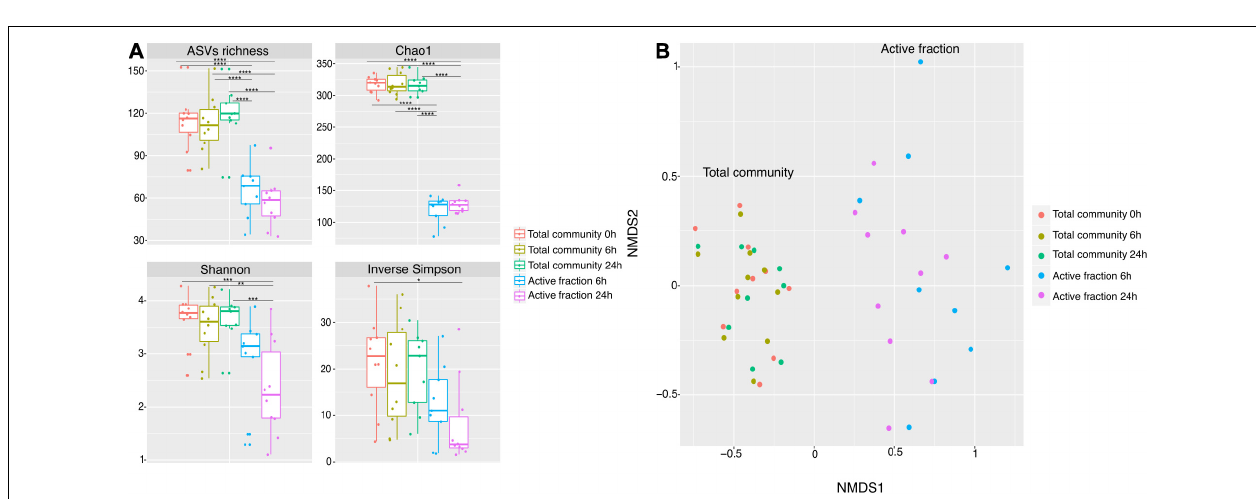
FIGURE 3 | The rutin-activated microbiota. (A) Relative abundance of metabolically-active cells in incubations. Relative standard deviation (RSD) was 1.0 for time 6 h and 0.43 for time 24 h. (B) Representative microscopic images of samples from three participants showing variability in cell morphology between donors. Active cells are represented in red (BONCAT-Cy5) and all cells are stained in blue (DAPI).